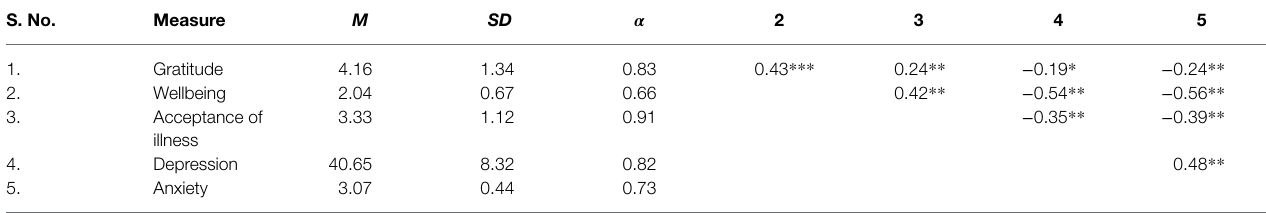
TABLE 1 | Descriptive statistics and correlations for